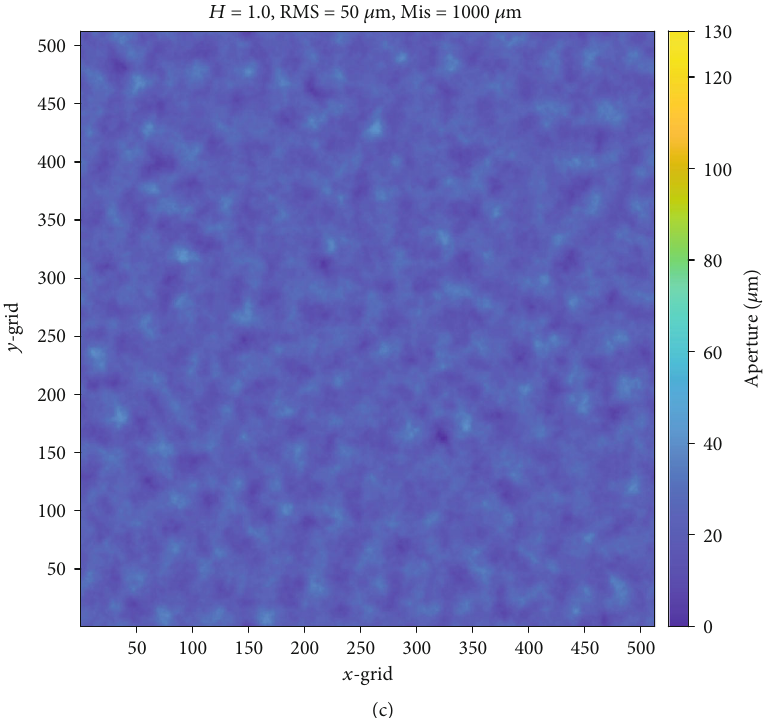
Figure 13: E ff ect of the H value on the aperture fi eld. RMS = 50 μ m and λ = 1000 μ m . The scale of the color bar is between 0 and 130 μ m. The c number of grids in the x and y directions is 512. (a) Aperture fi eld when H = 0 : 6 , which corresponds to surface pair 1 in Table 2; (b) aperture fi eld when H = 0 : 8 , which corresponds to surface pair 2 in Table 2; (c) aperture fi eld when H = 1 : 0 , which corresponds to surface pair 3 in Table 2. The H value is increased from (a) to